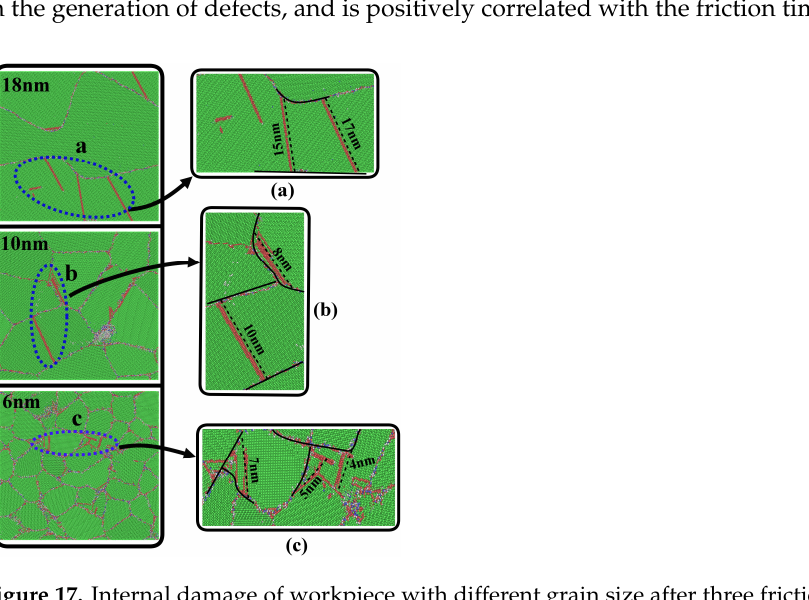
Figure 17. Internal damage of workpiece with different grain size after three frictions and figures ( a – c ) are the internal damage diagrams of different grain sizes. Coatings 2021 , 11 , x FOR PEER REVIEW